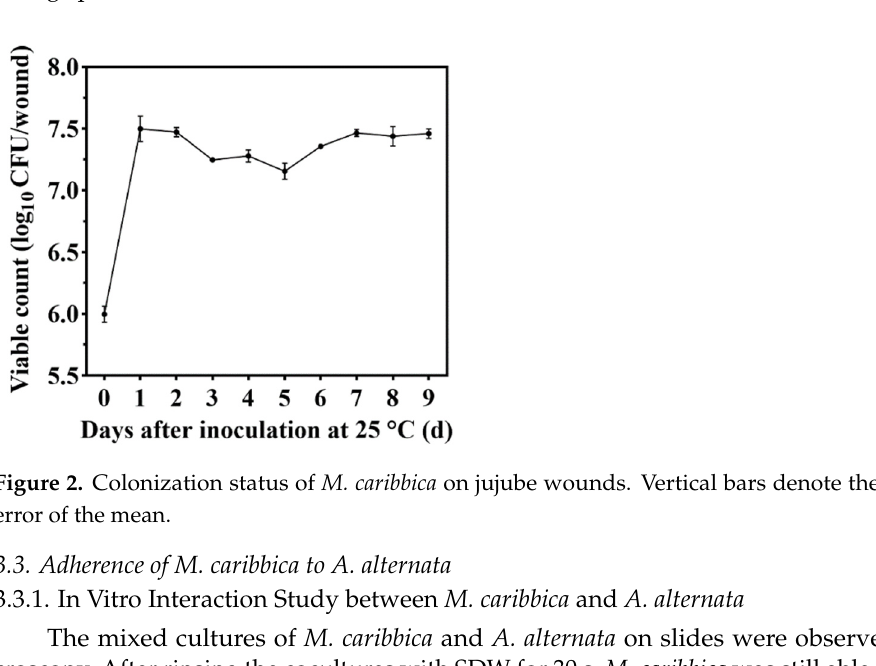
Figure 1. The biocontrol effect of M. caribbica inhibits A. alternata growth in jujube fruit. The ( A ) DI and ( B ) LD of jujube fruit were measured after inoculation at 25 °C. Standard errors of the means are indicated using vertical bars, and significant differences are denoted with different letters ( p < 0.05).